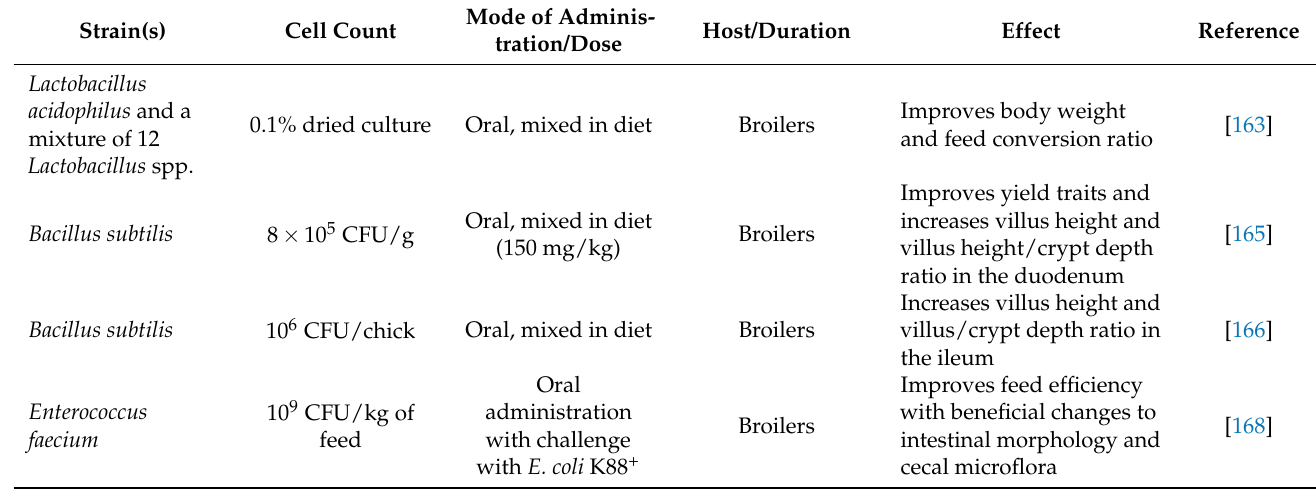
Table 4. Effect of probiotics on poultry